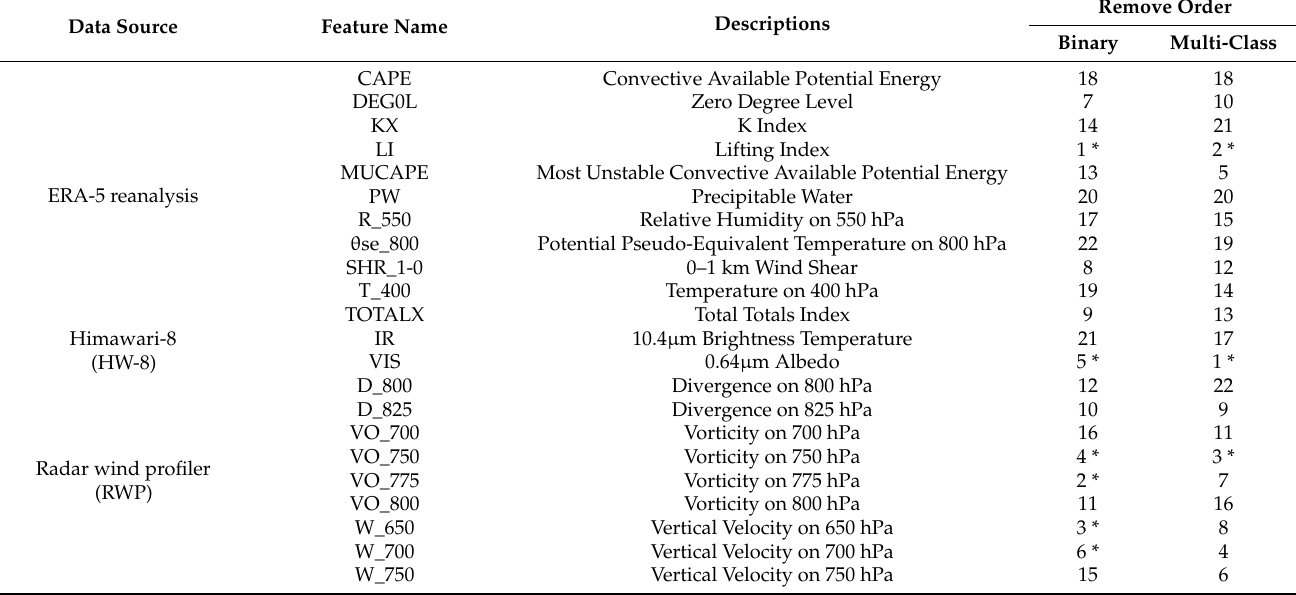
Table 2. The list of the input features of the RF models used in rainfall/non-rainfall forecast (binary) and rainfall grade forecast (multi-class). Note that the removal order of each undetermined feature is determined by the feature importance score of the RF model, and the removal order of features with a low score was the first. The optimal feature subsets of binary and multi-class prediction models determined by the backward sorting method are the features without asterisk